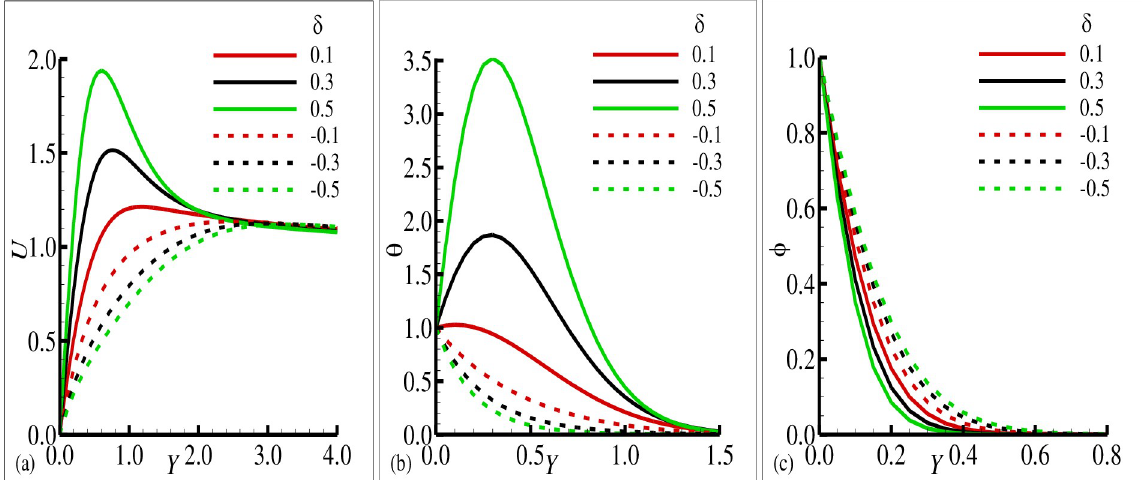
Fig 2. The graphical results for (a) velocity field u , (b) temperature field θ , and (c) magnetic field ϕ with various values of δ = 0.1, 0.5, 1.0 for heat source and δ = − 0.1, − 0.5, − 1.0 for sink, where others are γ = 0.5, Pr = 7.0, ξ = 0.2, λ = 0.1 and O = 0.05.